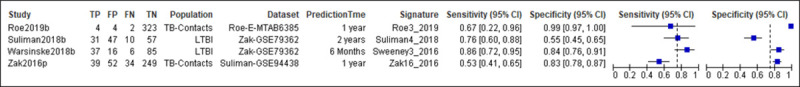
Forest plots of sensitivity and specificity of transcriptomic signatures for prediction of progression to TB disease in independent validation cohorts.Vertical dashed lines correspond to 75% sensitivity and 75% specificity. Prediction time is the time to TB disease used in each study.